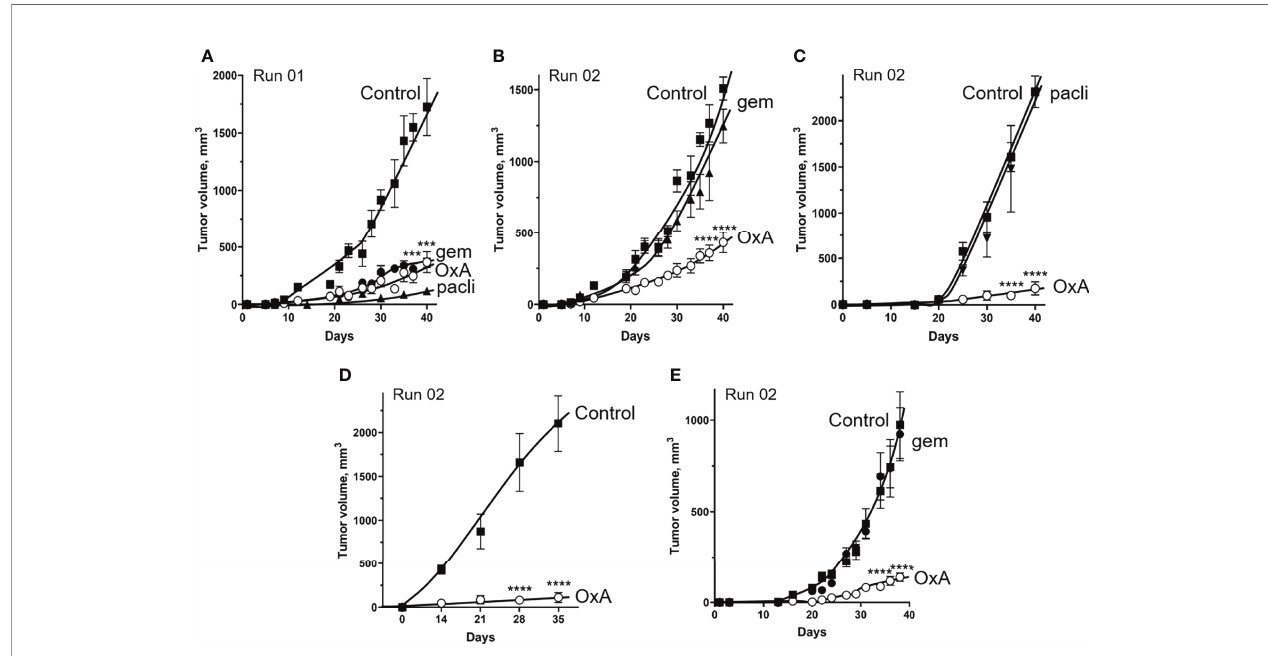
FIGURE 5 | Effect of OxA on tumor development of gemcitabine- and Nab-paclitaxel-chemoresistant tumors xenografted in nude mice. (A) A total of 2.10 6 AsPC-1 cells were subcutaneously injected in nude mice, which were treated by three injections/weeks of PBS (control), OxA (OxA), gemcitabine (gem), or Nab-paclitaxel (pacli). This fi rst step of the experiment was noted as “ Run 01. ” After 40 days, mice were sacri fi ced, and resected tumors were dissociated with collagenase and subcutaneously reinjected in nude mice. This step was named “ Run 02 ” of experiments. (B) The impact of OxA and gemcitabine on tumor development of gemcitabine-treated tumors xenografted in nude mice (Run 02). (C) Impact of OxA and Nab-paclitaxel on tumor development of NAB-paclitaxel-treated tumors xenografted in nude mice (Run 02). (D) Impact of OxA on tumor development of OxA-treated tumors xenografted in nude mice (Run 02). (E) The impact of OxA and gemcitabine (Run 02) on tumor development of gemcitabine-treated tumors from Run 01 experiment in which tumors were obtained by xenografting of 2.10 6 PDAC15 (PDX) cells. Data were the means ± SEM of six tumors in each group. ***p<0.001 and